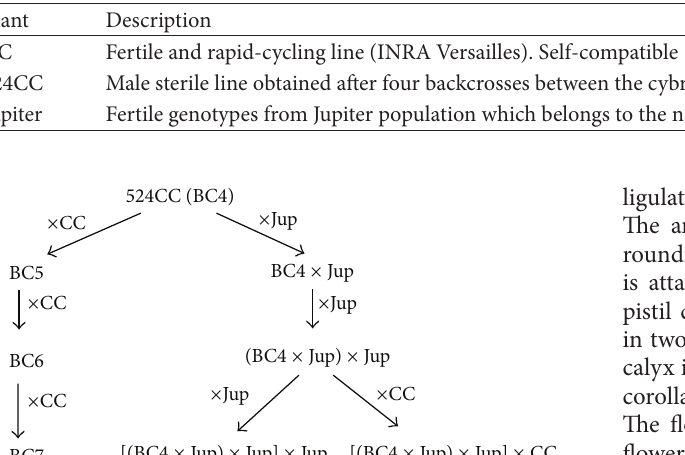
Table 1: Parents used for morphological analysis and for different crosses.